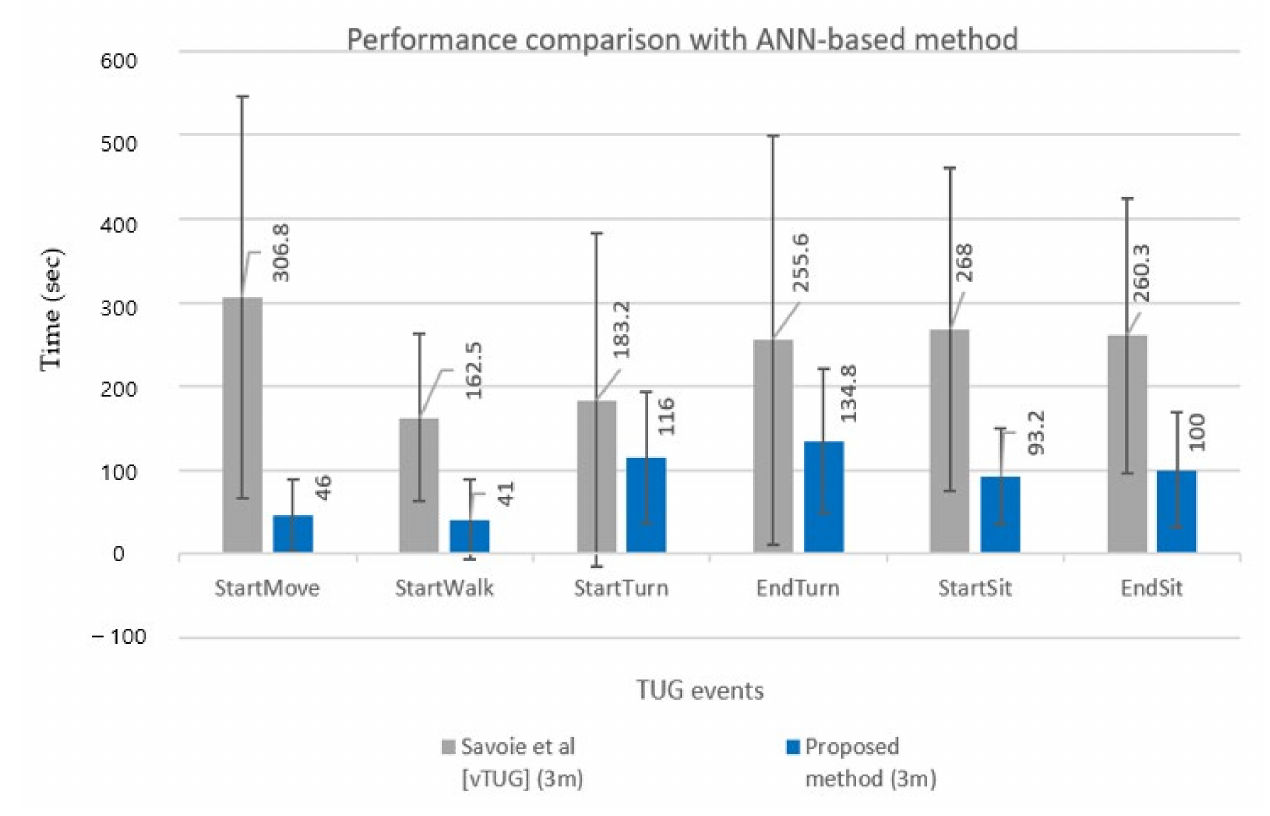
Figure 11. Comparison results with ANN-based method